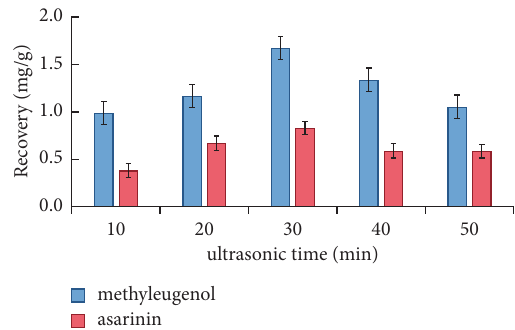
Figure 5: Effect of DES volume, extraction conditions: sample amount, 50mg; molar ratio, 1: 2; ultrasonic temperature, 60 ° C; ultrasonic time, 30min; and vortex oscillation, 5 min.